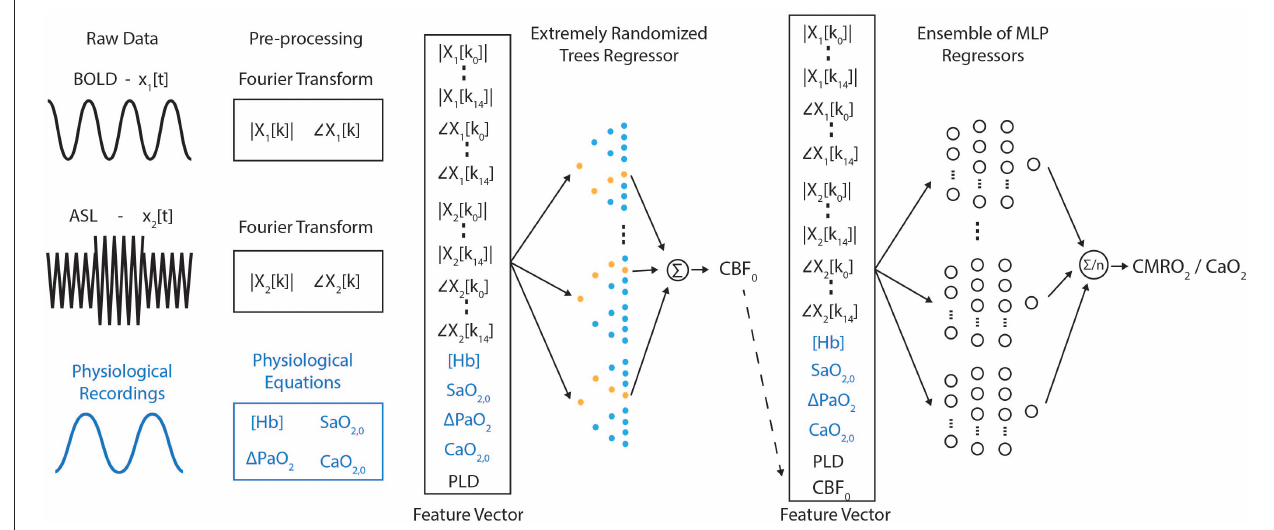
FIGURE 2 | Schematic diagram of the frequency-domain machine learning pipeline. Raw data is pre-processed prior to the construction of a feature vector. This initial feature vector is used to estimate baseline perfusion. The perfusion estimate is then included in the feature vector fed into an ensemble of multilayer perceptron networks used to estimate the resting rate of oxygen